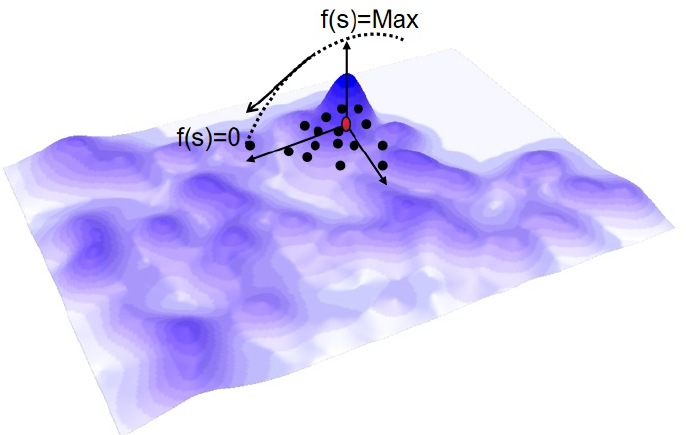
Figure 3. Diagram of the kernel density calculation.